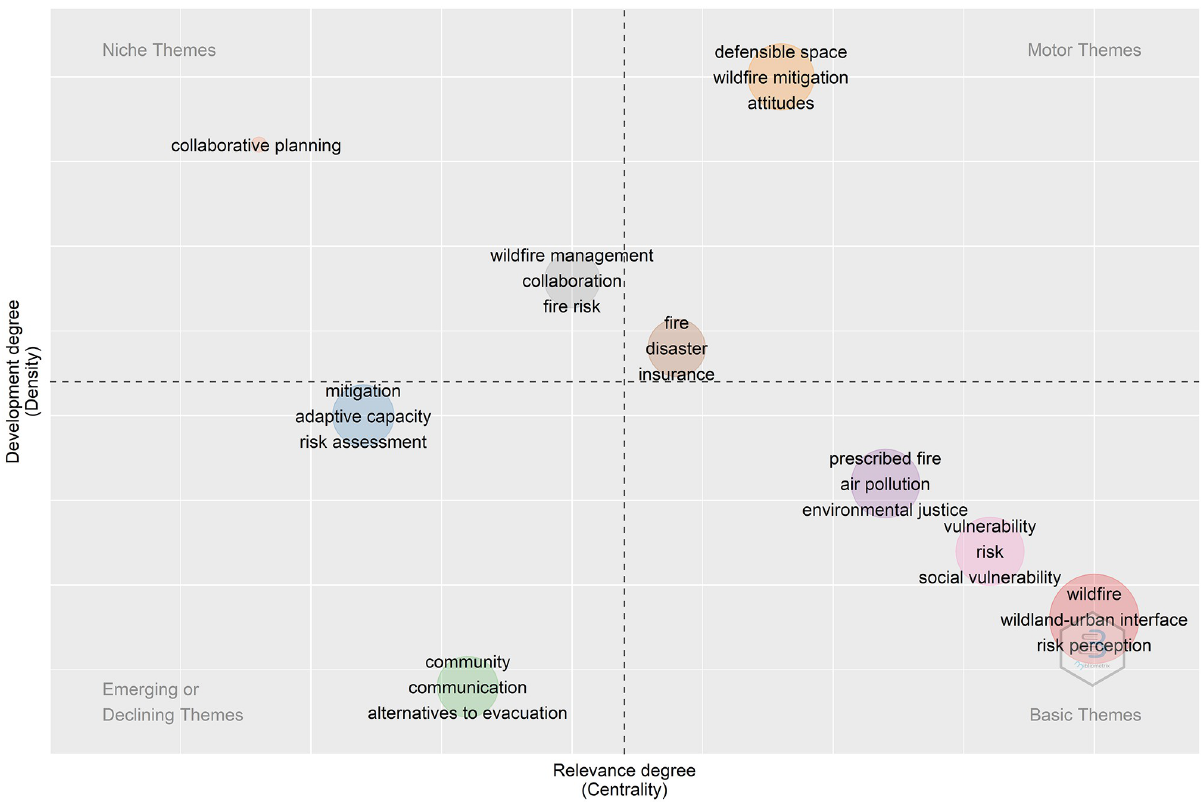
Fig 4. Thematic map of development and relevance degree of the socio-demographic dimensions of wildfire literature based on author provided keywords.